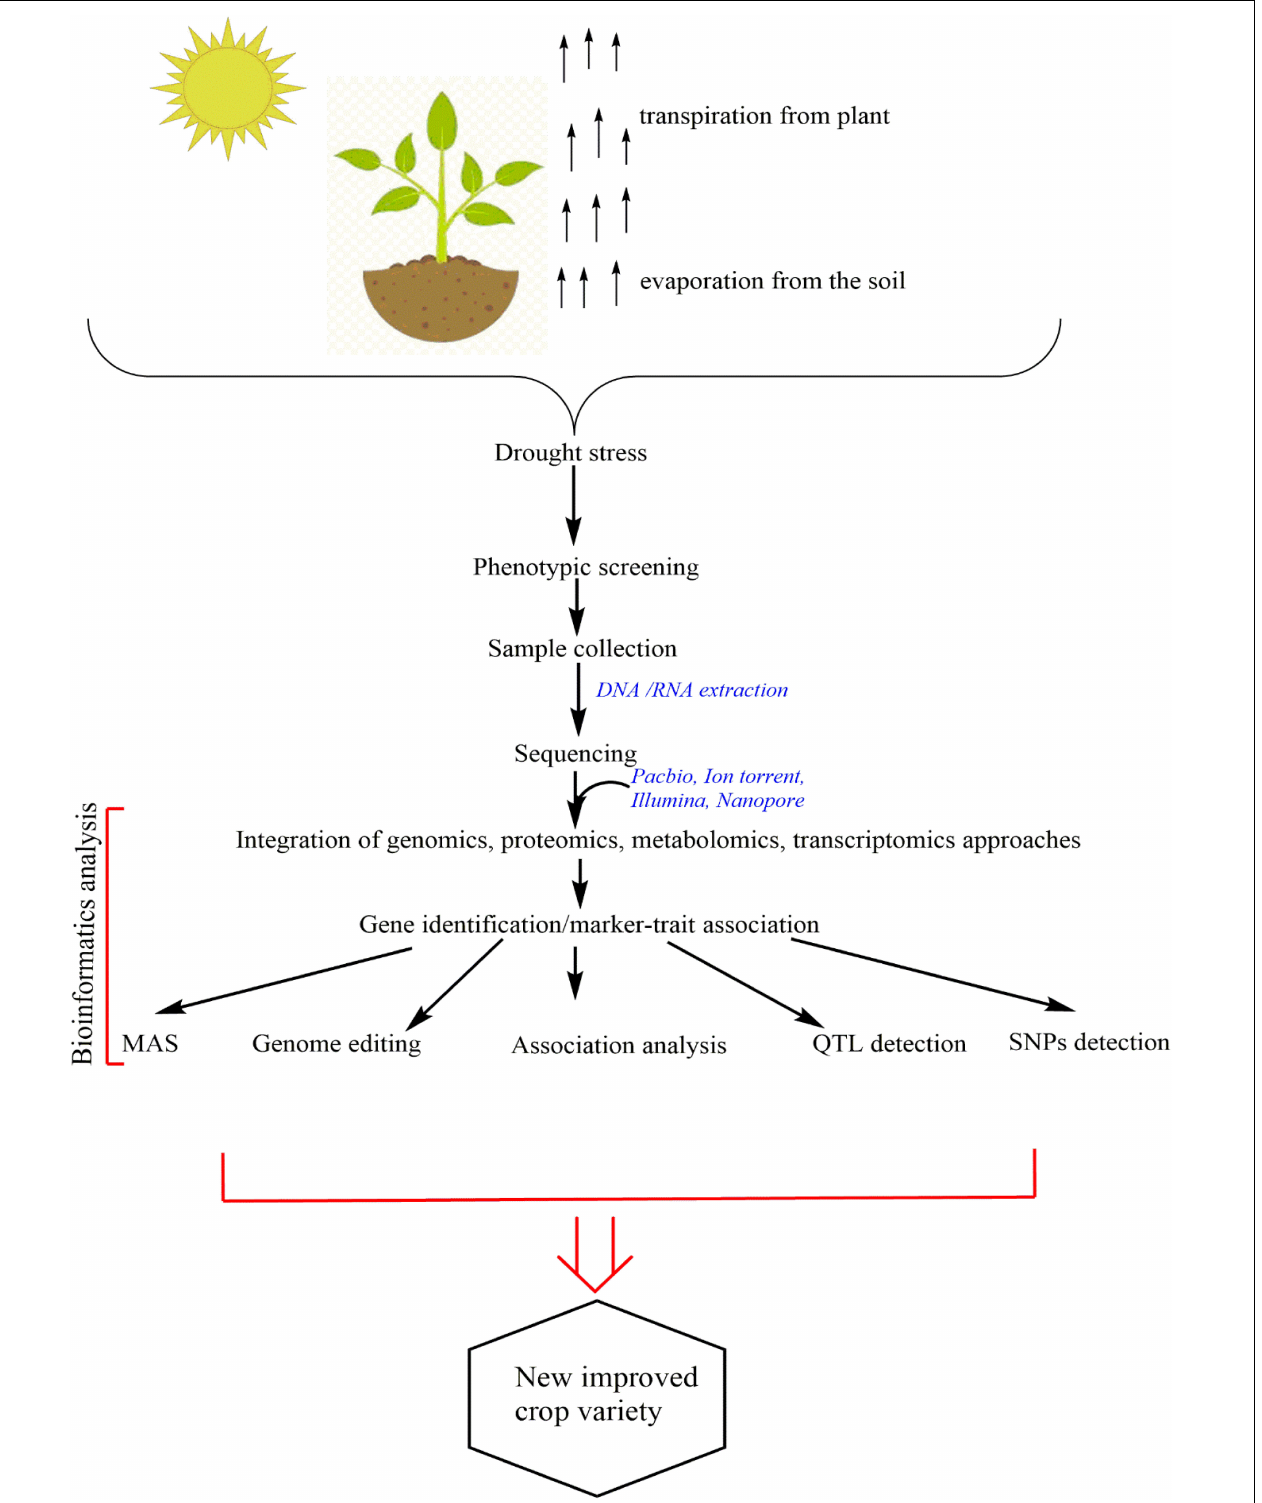
FIGURE 4 | Schematic representation of drought